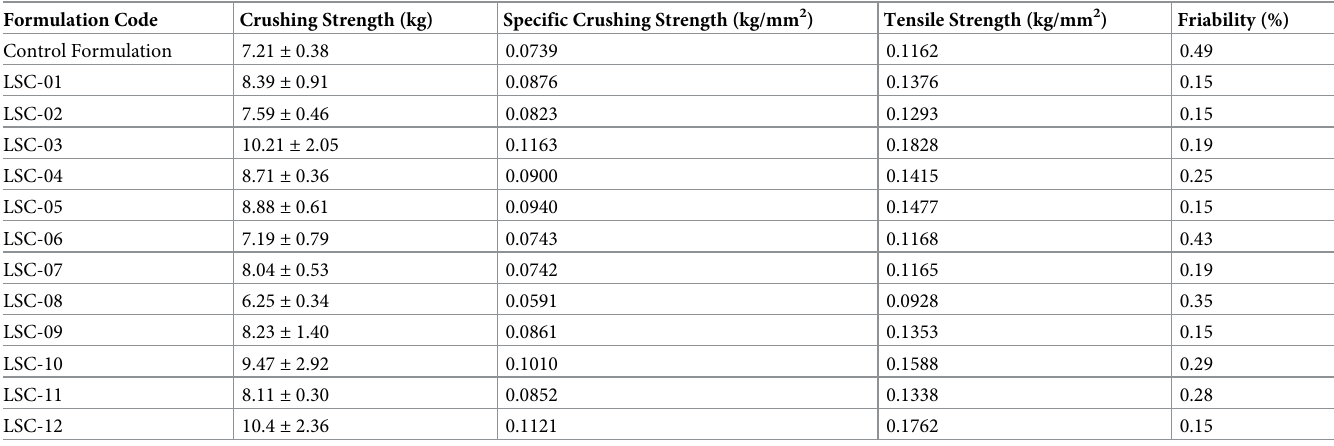
Table 6. Mechanical strength of liquisolid compacts of clopidogrel. Formulation Code